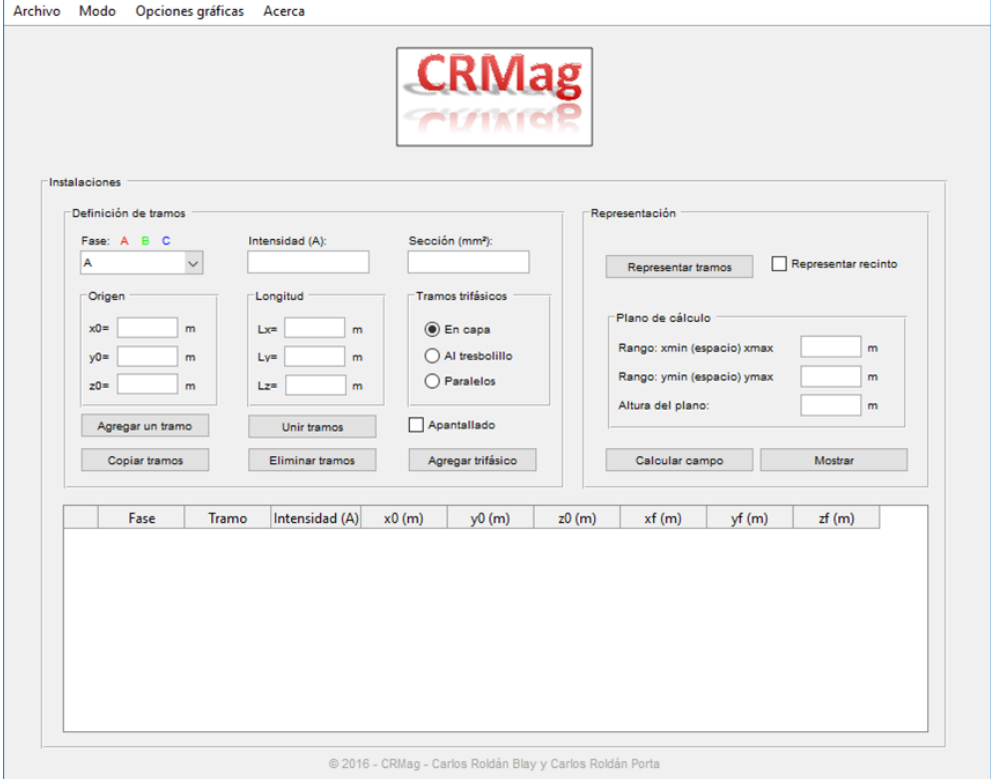
Figure 1. Main screen of the CRMag® software.